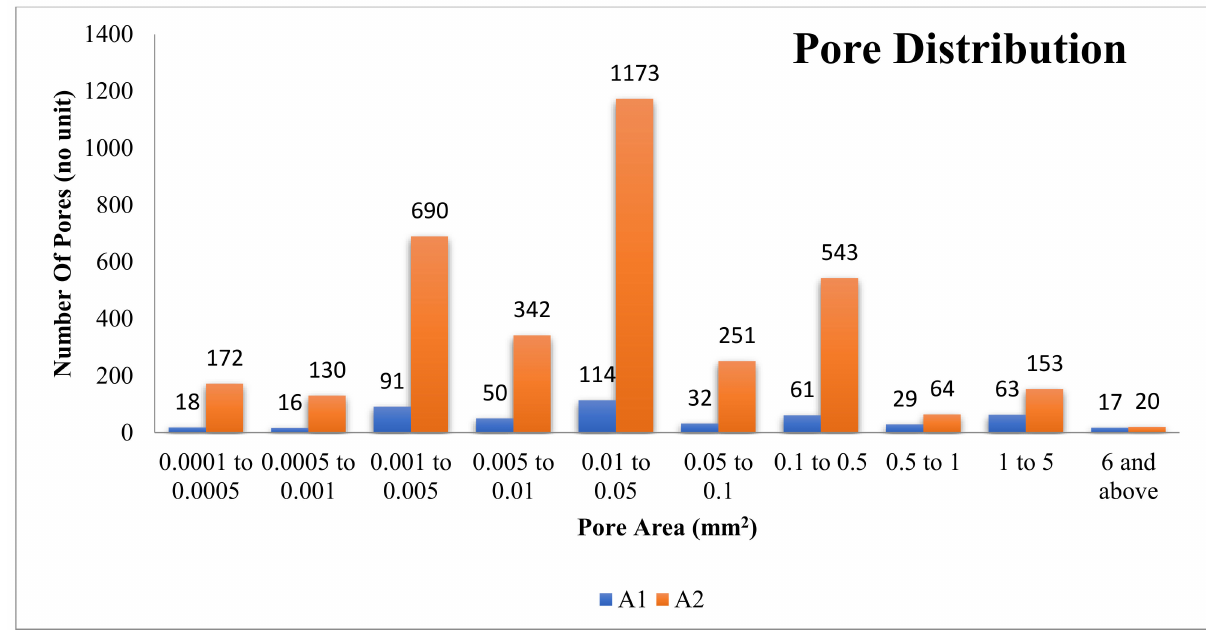
Figure 8. Distribution of pore area (mm 2 ) and the number of pores inside the structure of the A1 and A2 models. After importing the model into the Meshmixer software, it is then aligned at the base point, and it distinguishes the solid and the inner pore structure, which is shown in Figure 9. The cropped 3D model of the A1 and A2 samples and the formation of pores inside the structure are shown in Figure 10 below.